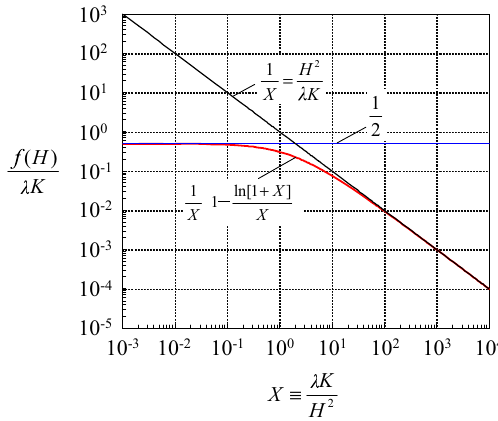
Fig. 1 Properties of the normalized extra driving term f ( H )/(λ K ) . The horizontal axis is X ≡ λ K / H 2 . The logarithmic formula given by Eq. (39) is plotted. The two approximation curves for 1 / 2 and 1 / X given by Eq. (42) are also shown